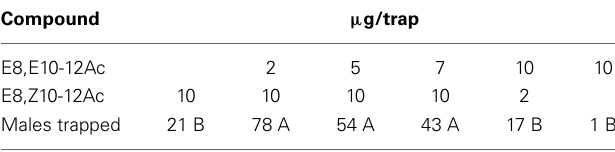
Table 3 | Field attraction of C. splendana males to synthetic pheromone blends in an oak forest (Scania; N = 10).